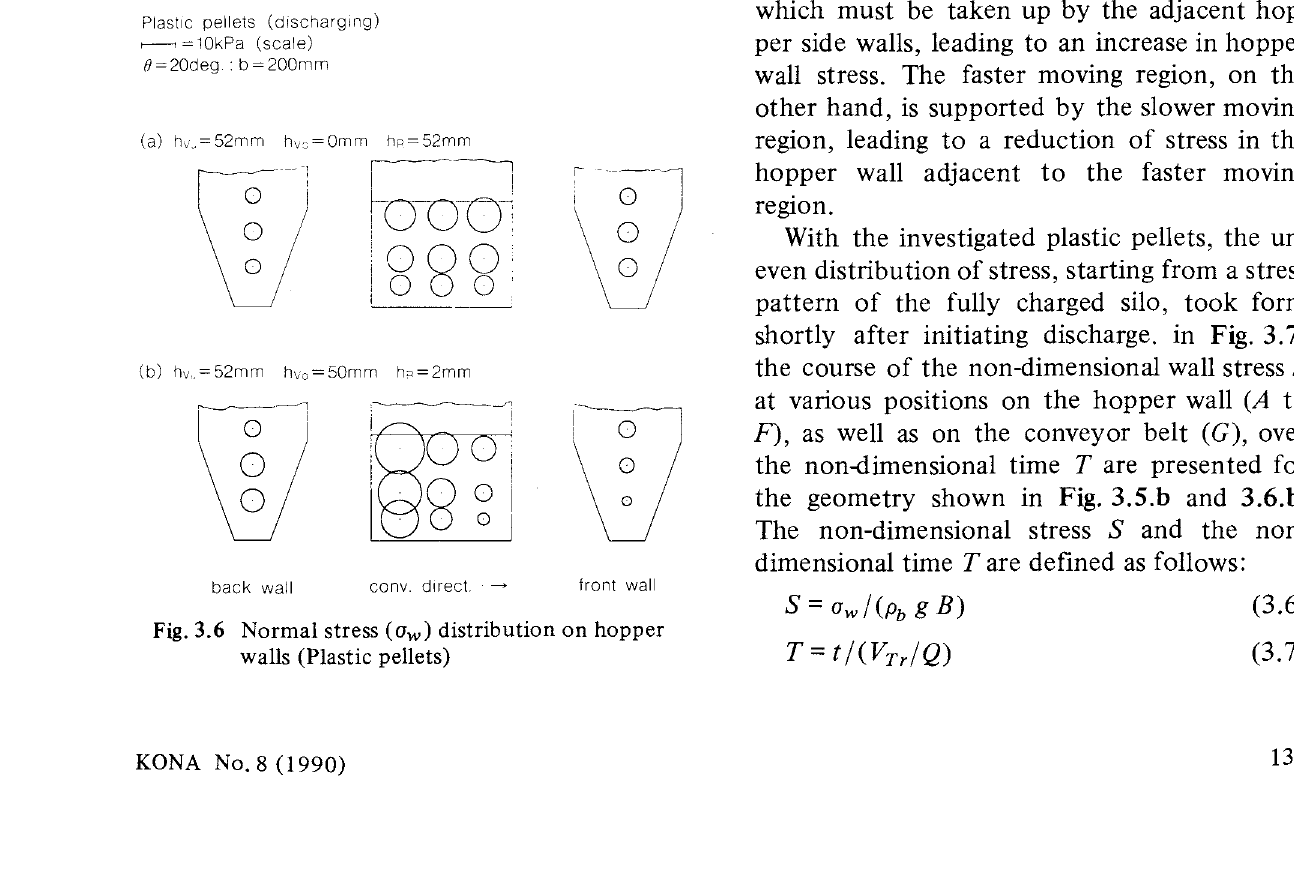
Fig. 3.5 Velocity distribution on hopper side wall (Plastic pellets) interpolation method. Fig. 3.5 shows the meas ured velocity vectors at one of the hopper side walls during discharge for two different geome tries of the hopper/feeder interface. The length and direction of each vector line represent the magnitude and the direction of the velocity at that point. The geometry (a), shown on the left of Fig. 3.5, yields a relatively even velocity dis tribution, the geometry (b) on the right side a PlastiC pellets (drschargmg) r----; = 10kPa (scale)